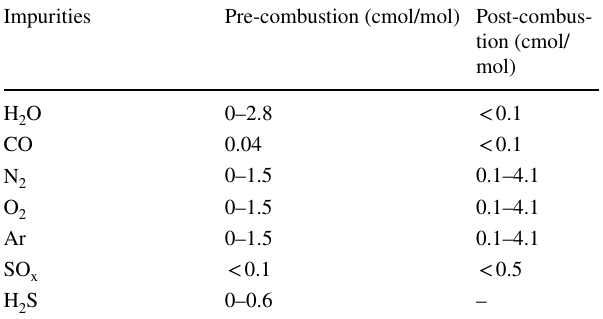
Fig. 4 Classification of impurities in